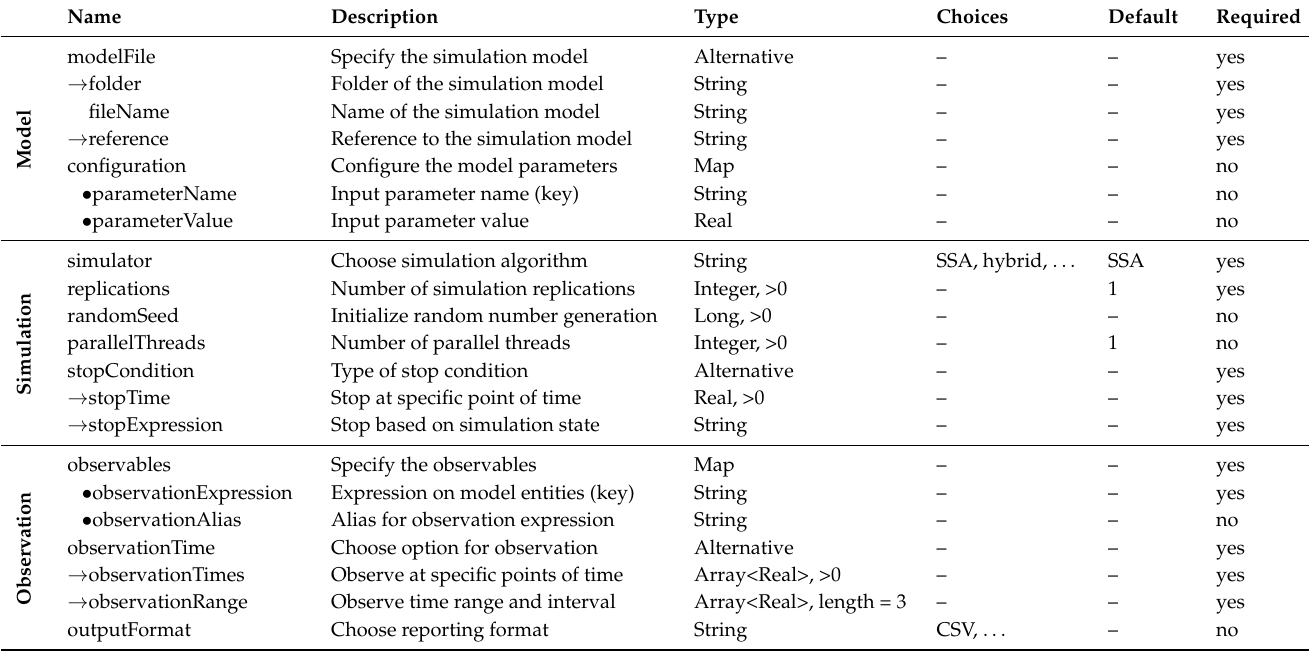
Table 1. Base meta model for conducting experiments using stochastic discrete-event simulation. To create a valid simulation experiment, various information about the model, the simulation, and the observed quantities has to be provided. Each row describes an input property of the meta model. Sub-properties are denoted by “ • ”. Alternative meta model parts are indicated by “ →